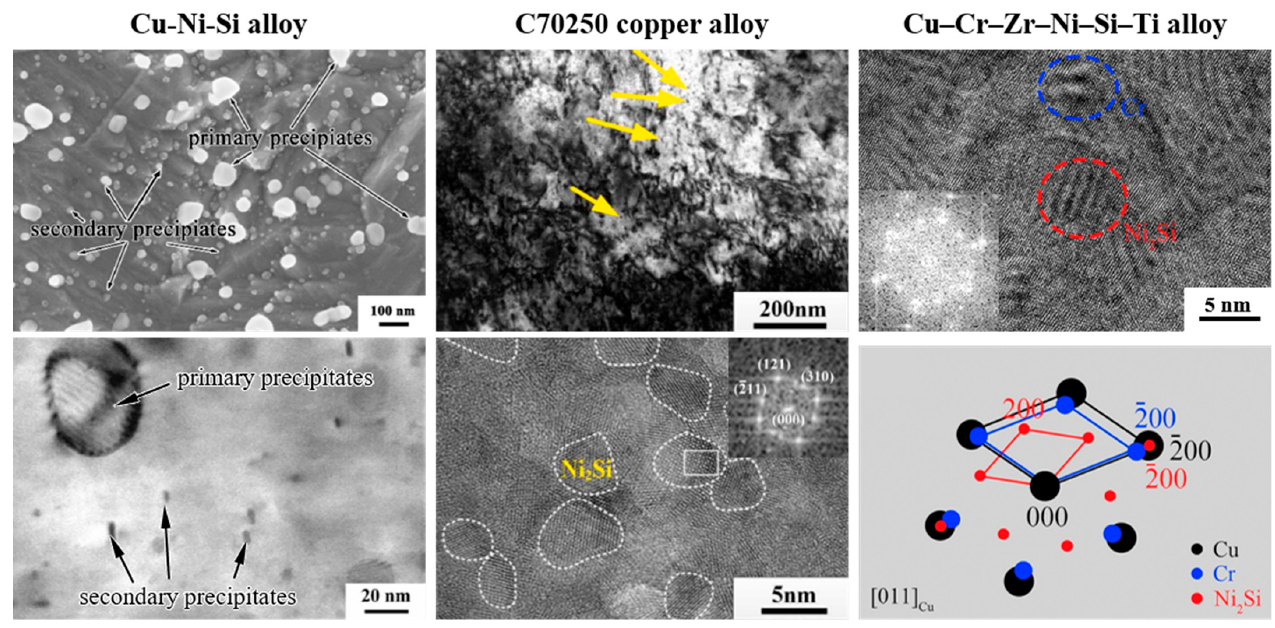
Figure 11. The micrograph of refined precipitates and the orientation relationship between the precipitates and the Cu matrix in Cu-Ni-Si alloy, reprinted with permission from ref. [98], 2022, Elsevier; C70250 alloy (Ni 2 Si phase is marked by yellow arrows, and the Fast Fourier Transform (FFT) diffraction pattern of Ni 2 Si in white square), reprinted with permission from ref. [99], 2022, Elsevier; and Cu-Cr-Zr-Ni-Si-Ti alloy, respectively, reprinted with permission from ref. [101], 2022,